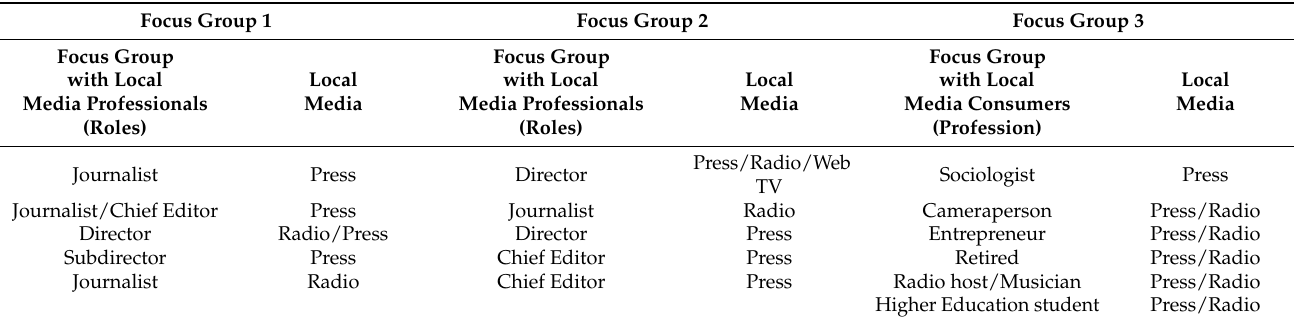
Table 1. Distribution, roles, and local media of participants by focus